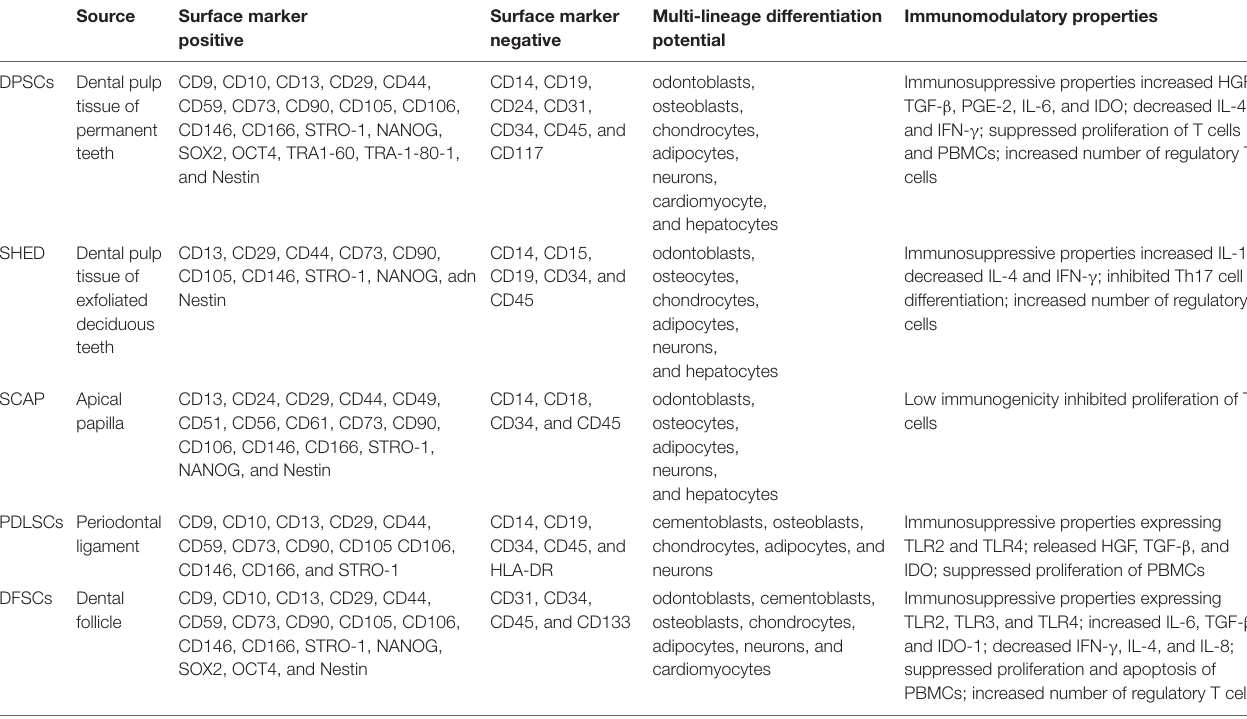
TABLE 1 | Comparison of root formation-related dental MSCs in immature permanent